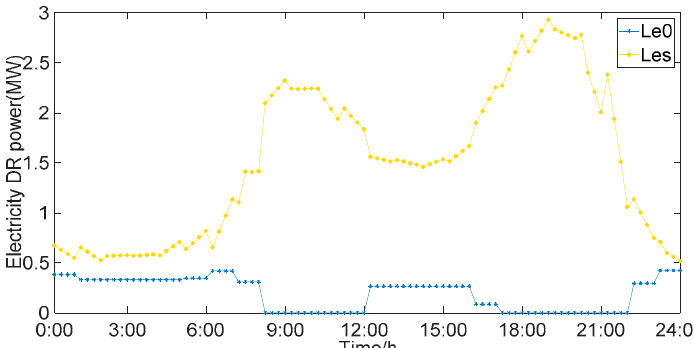
T T = 3 h. ( b ) c = 1 h.